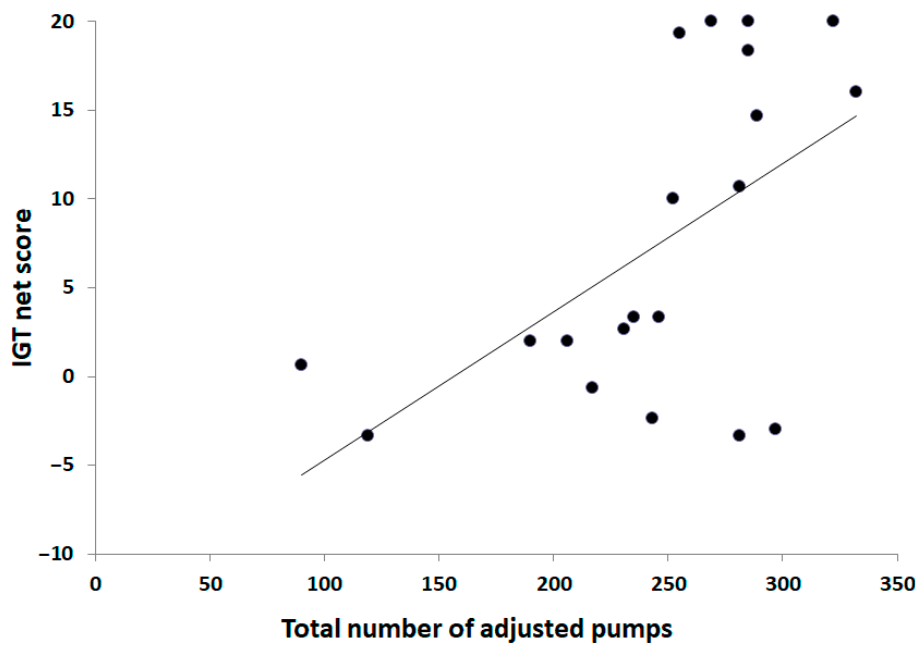
Figure 1. Scatterplot of the relationship between the total number of adjusted pumps in the 10 first trials and the net score on the Iowa Gambling Task (IGT) during the last 60 trials for all participants.